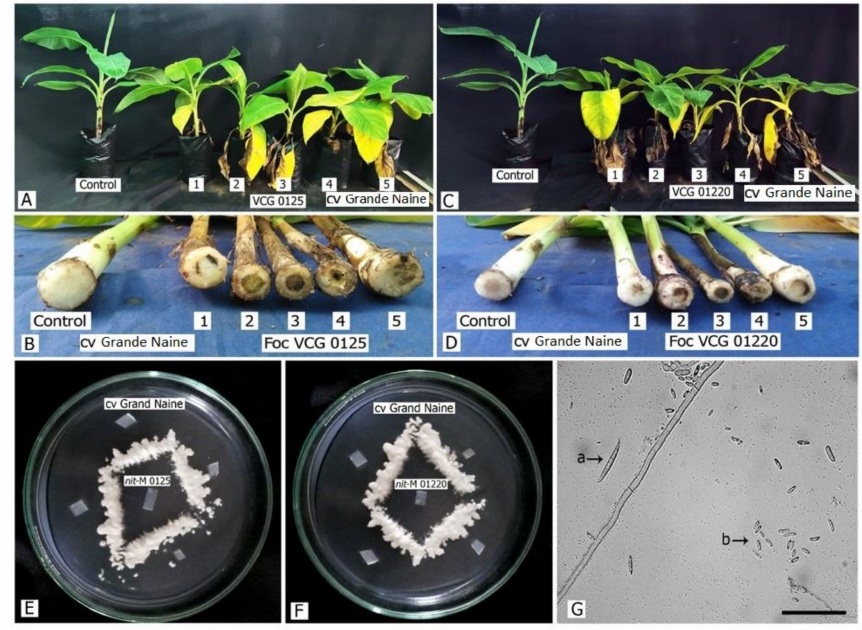
Figure 4. Banana cv. Grande Naine 25–30 days after inoculation with different races of Foc isolates. ( A , C ): Pathogenicity test of VCG0125 and VCG01220; ( B , D ): Cross-section of rhizome for vascular discoloration; ( E , F ): isolation and confirmation of VCGs by nit-M testers; and ( G ): Spore morphology of 7 days old culture of Foc VCG 0125 where a: macroconidia and b: microconidia, the scale bar